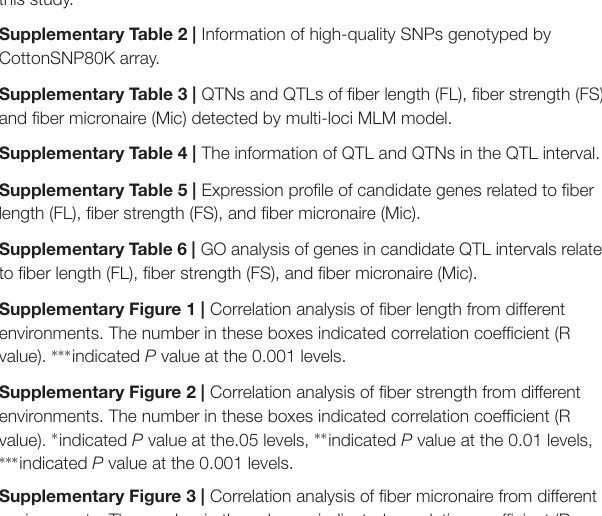
Supplementary Table 1 | Information of 242 upland cotton accessions used in this study.